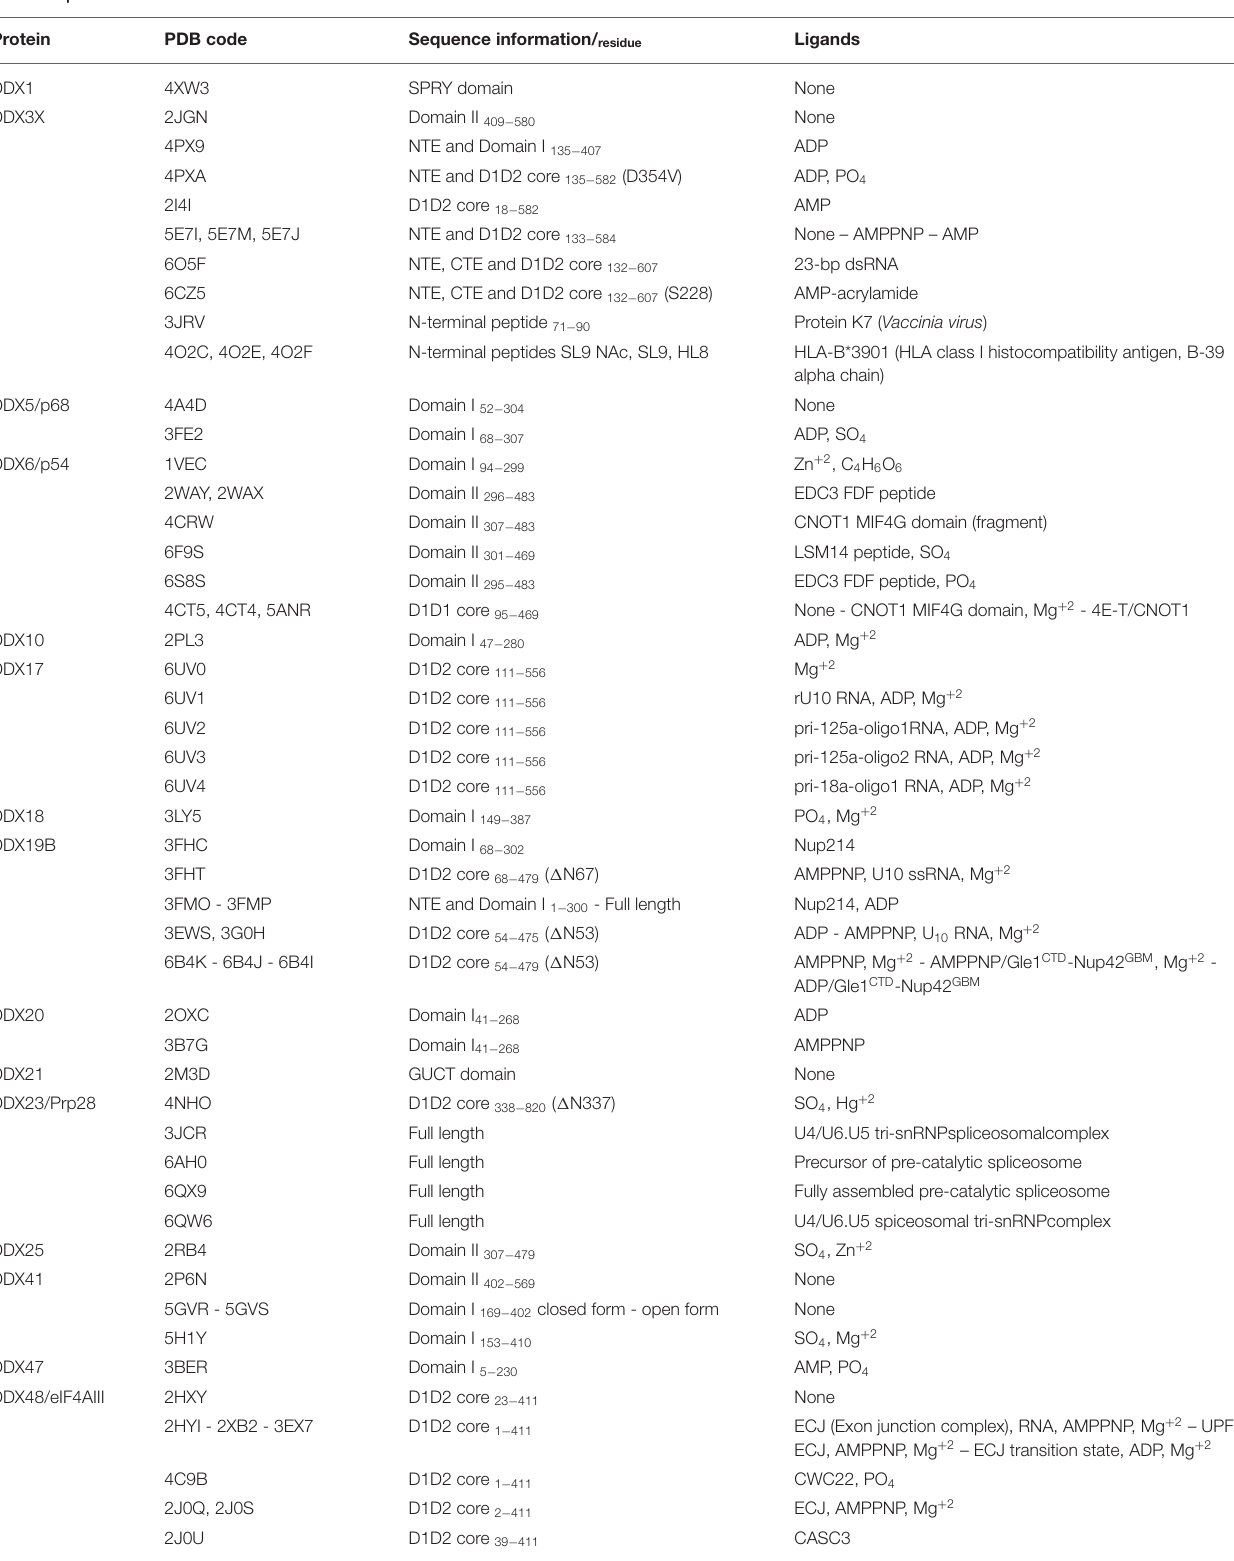
TABLE 3 | Structures of DDX helicases.